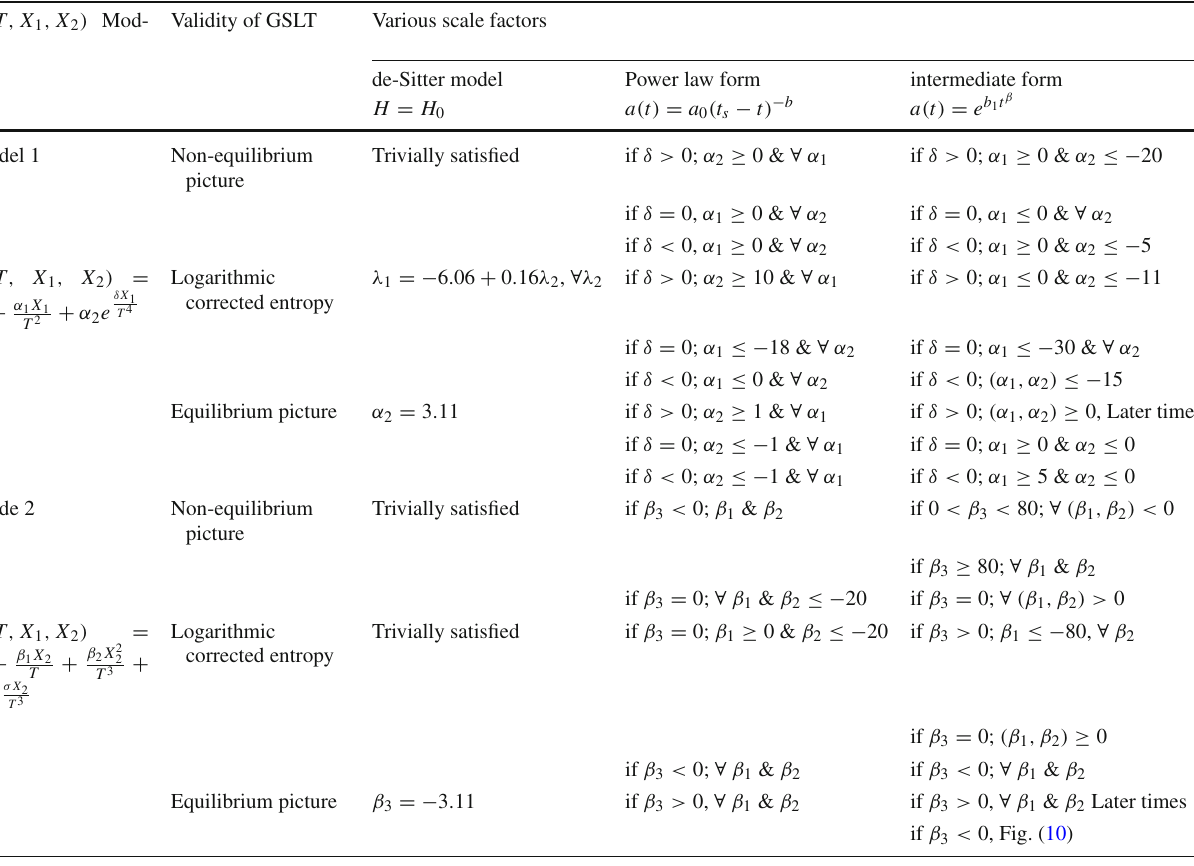
˙˜ S tot ≥ 0 for different models Validity of GSLT